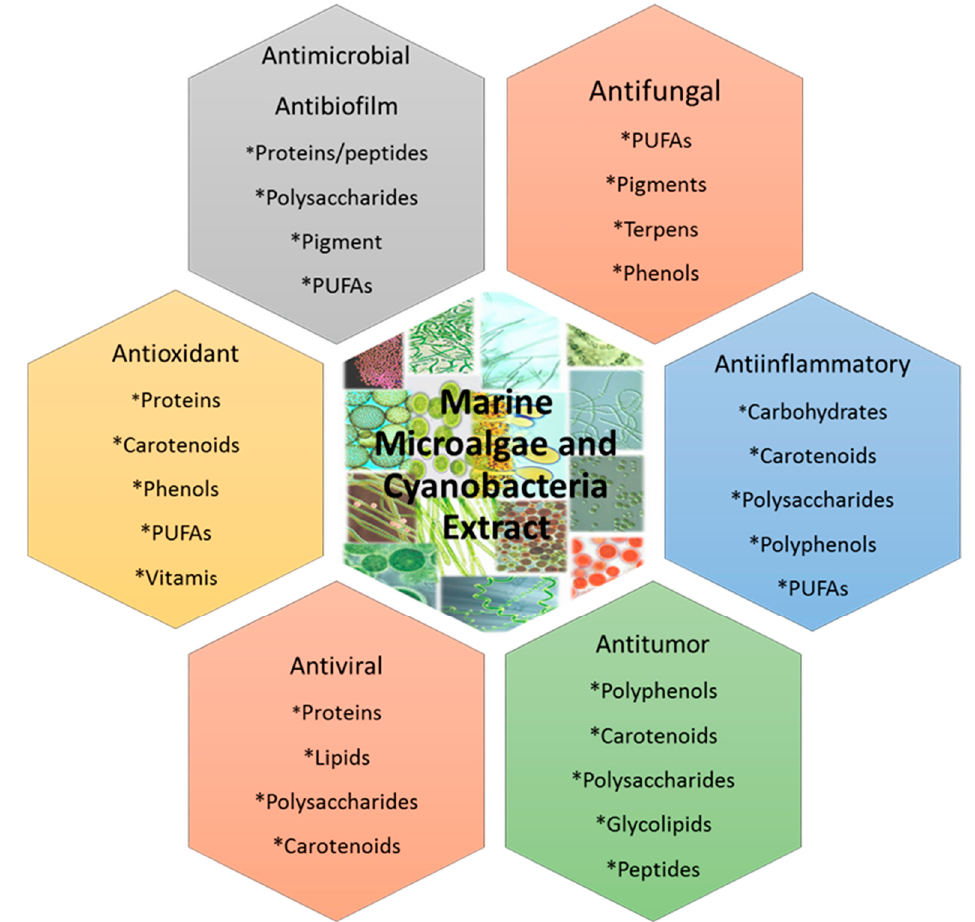
Figure 3. Properties of the biologically active compounds from marine microalgae and cyanobacteria.